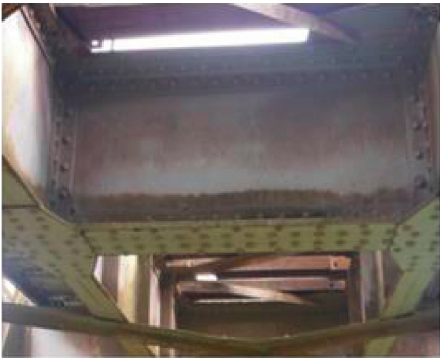
Figure 5: Corrosion of the deck’s steel members (bottom view).